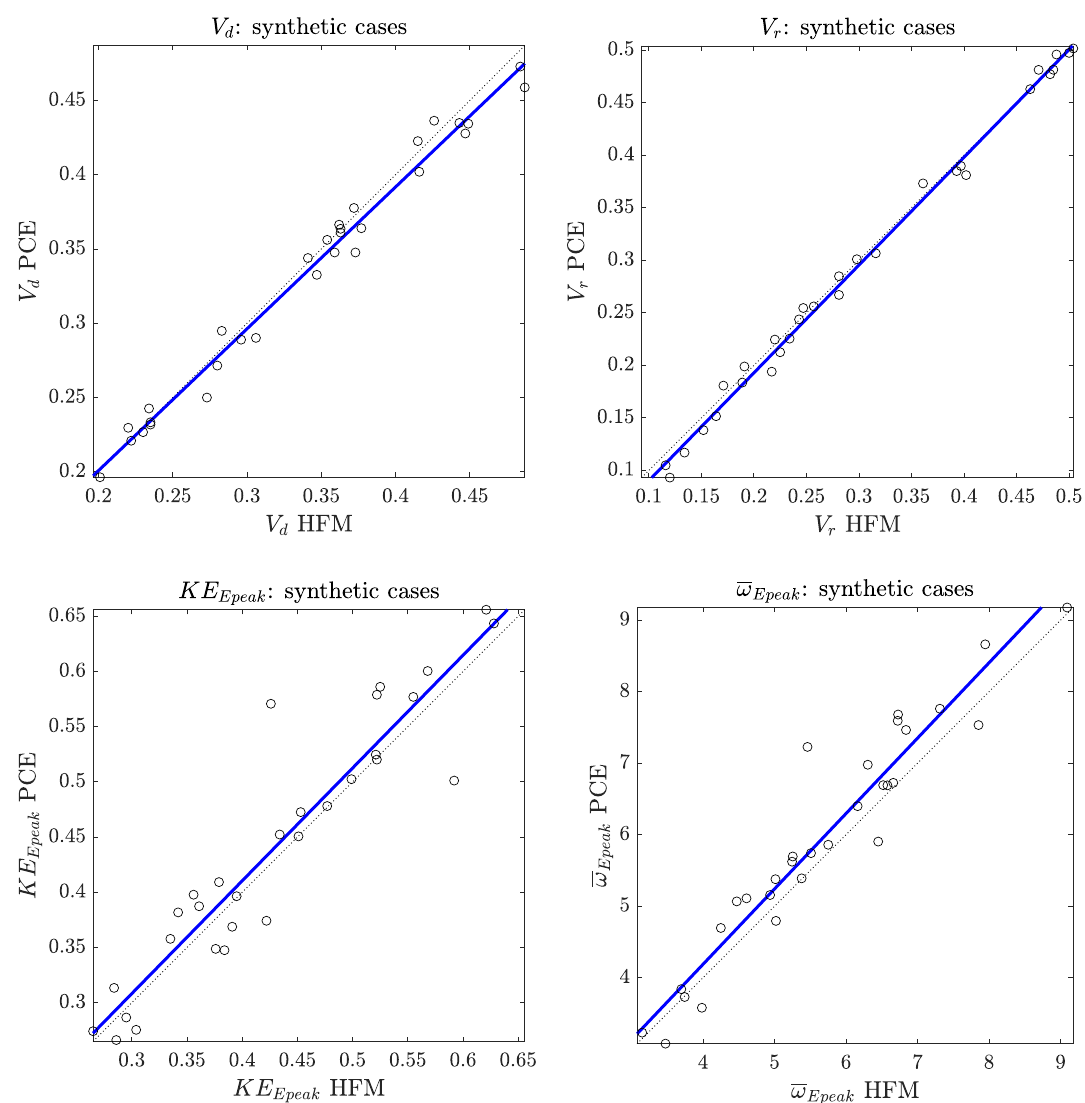
Figure 1. Comparison between HFM and PCE predictions against synthetic cases. Solid blue lines represent the linear regressions, while dashed lines are the bisectors. Characteristics of regression lines: V d PCE = 0.95 · V d HFM + 0.0099 ( R 2 = 0.98, p − value = 9.74 E − 27 ) ; V r PCE = 1.00 · V r HFM − 0.012 ( R 2 = 0.99, p − value = 3.29 E − 33 ) ; KE Epeak PCE = 1.00 · KE Epeak HFM + 0.0018 ( R 2 = 0.87, p − value = 4.68 E − 14 ) ; ω Epeak PCE = 1.10 · ω Epeak HFM − 0.029 ( R 2 = 0.92, p − value = 1.50 E − 16 )